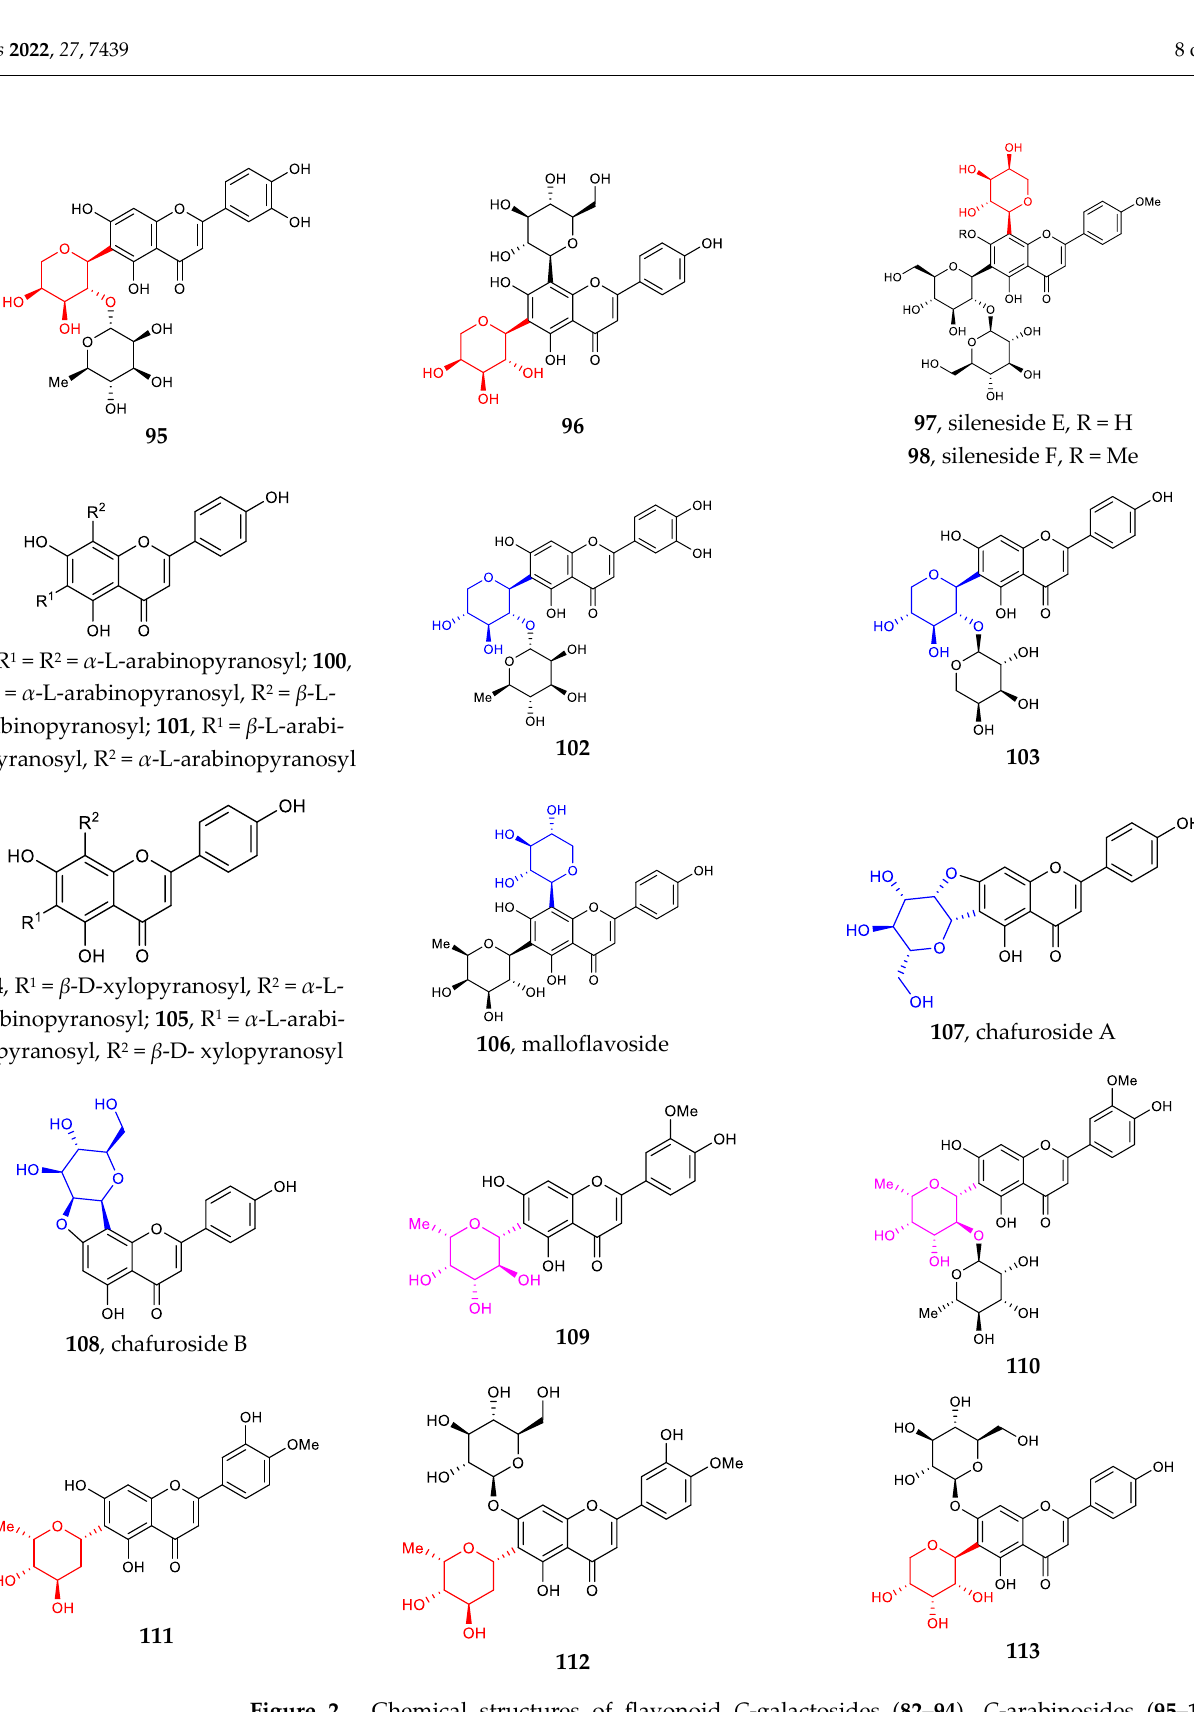
Figure 2. Chemical structures of flavonoid C -galactosides ( 82 – 94 ), C -arabinosides ( 95 – 101 ), C -xylosides ( 102 – 106 ), C -mannosides ( 107 – 108 ), C -fucosides ( 109 – 110 ), C -boivinosides ( 111 – 112 ), and C -riboside ( 113 ).